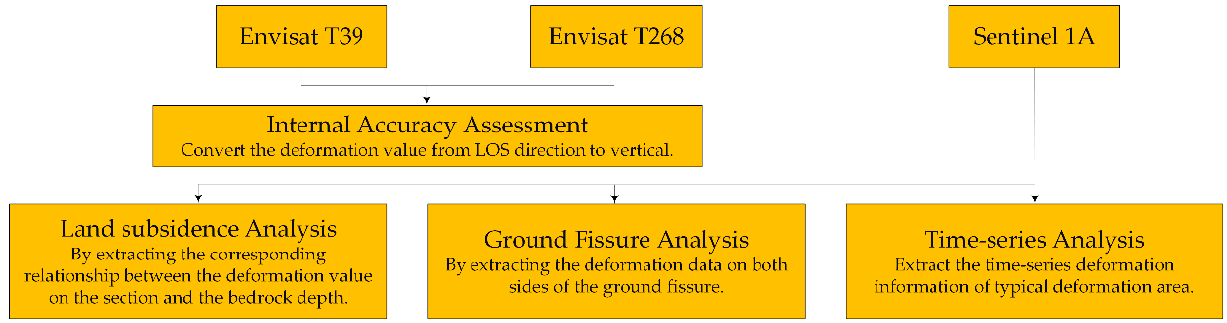
Figure 4. Flow chart of deformation field analysis .